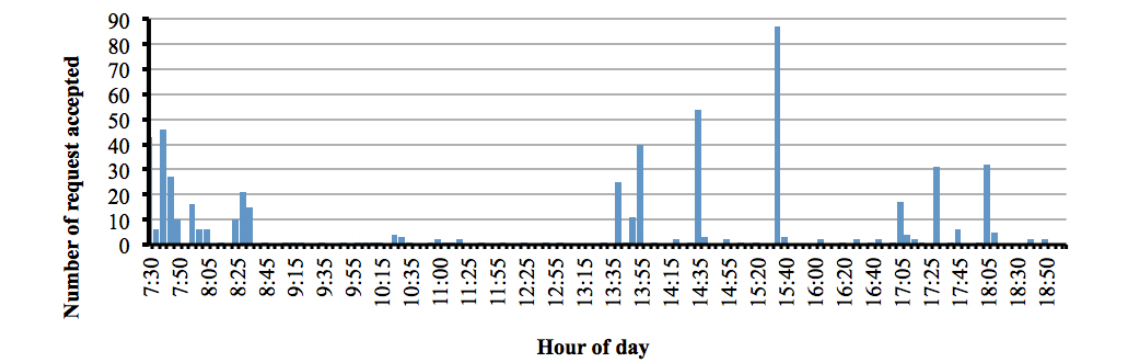
Figure 4. Daily transport request distribution from 19 May–31 October